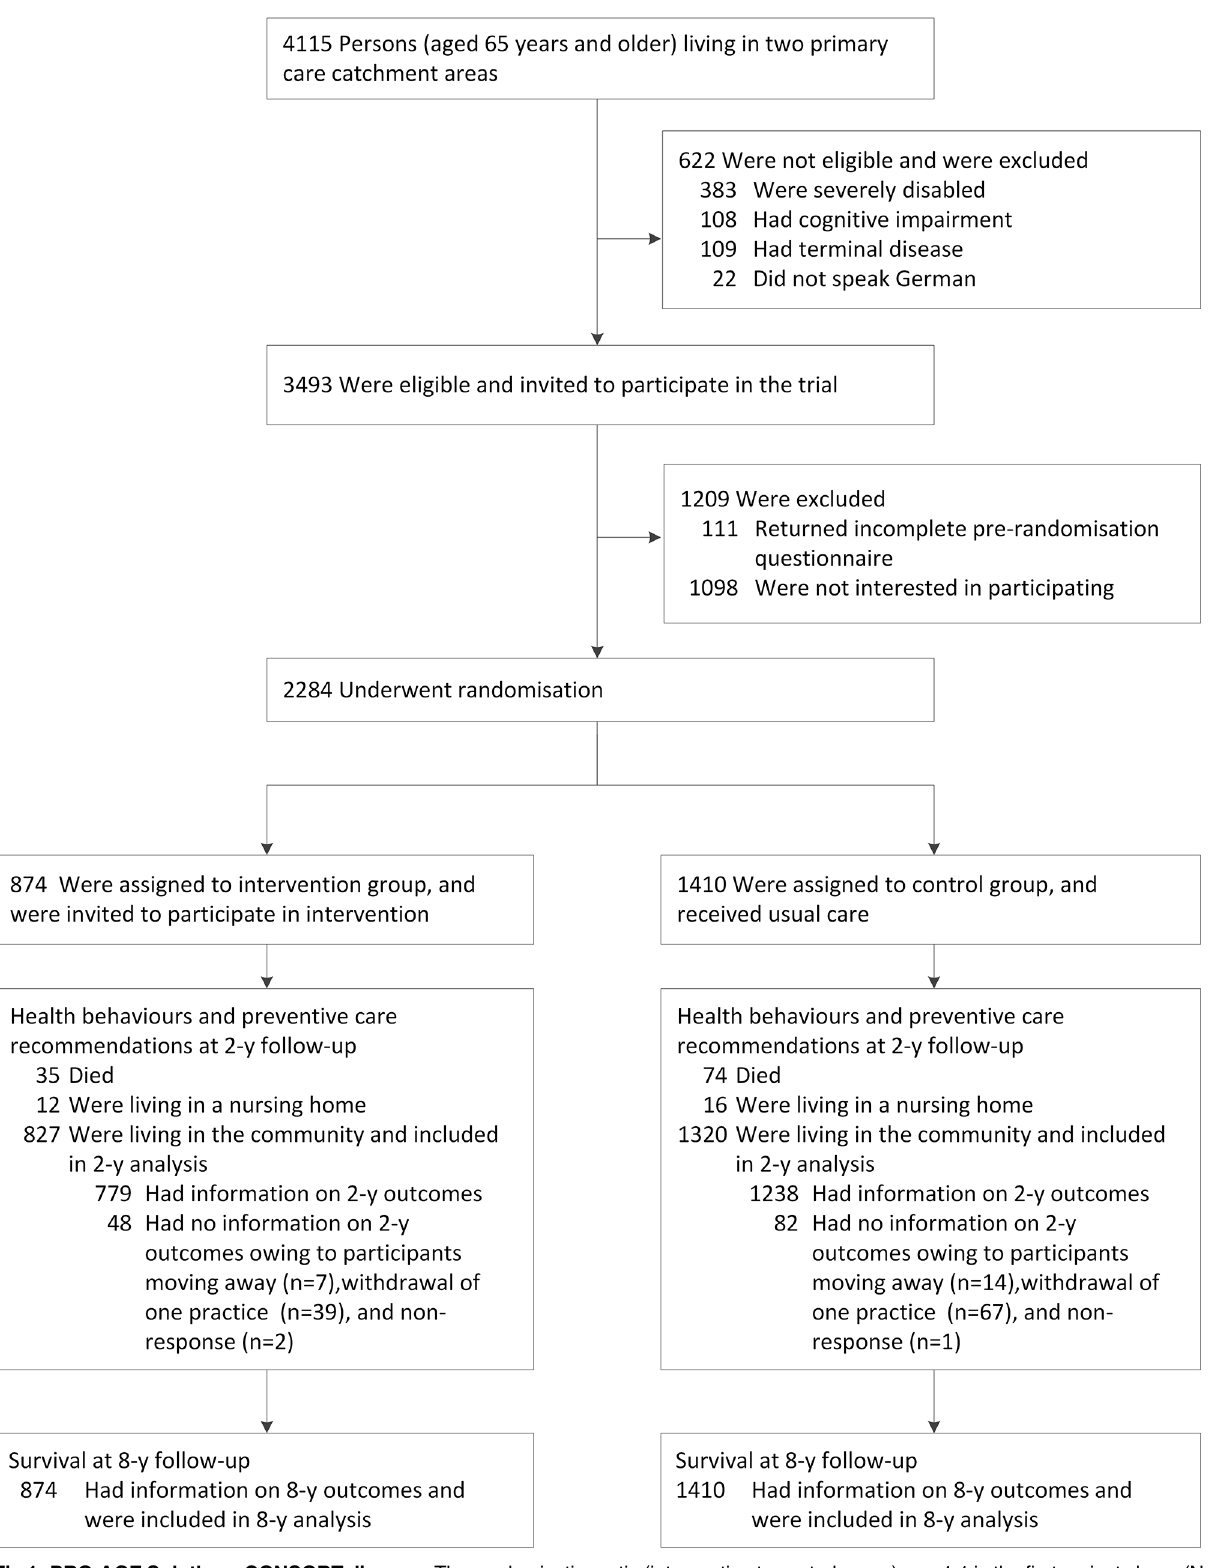
Fig 1. PRO-AGE Solothurn CONSORT diagram. The randomisation ratio (intervention to control group) was 1:1 in the first project phase (November 16, 2000, to March 27, 2001), and 1:2 in the second project phase (March 28, 2001, to January 8, 2002), resulting in a ratio overall of 1:1.6. doi:10.1371/journal.pmed.1001889.g001 PLOS Medicine | DOI:10.1371/journal.pmed.1001889 October 19,